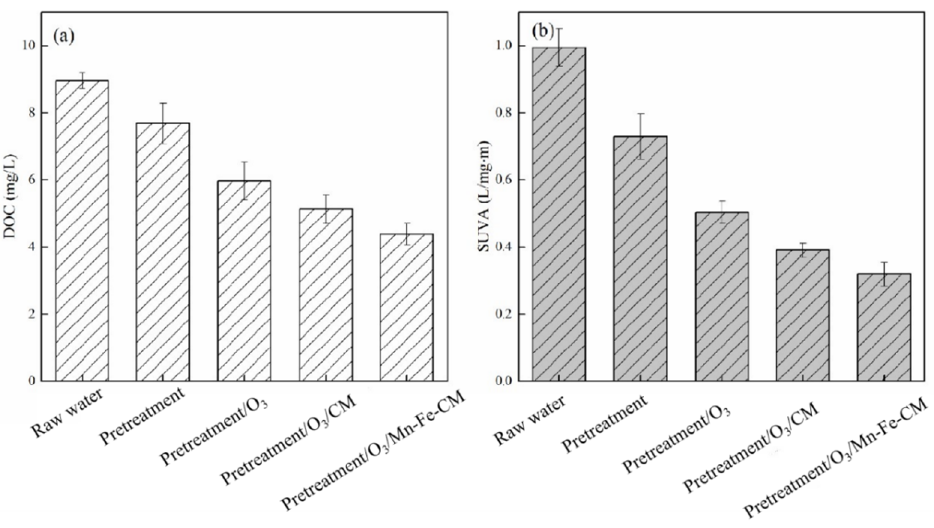
Figure 2. Water discharge along the course: ( a ) DOC variation characteristics, ( b ) SUVA variation characteristics.